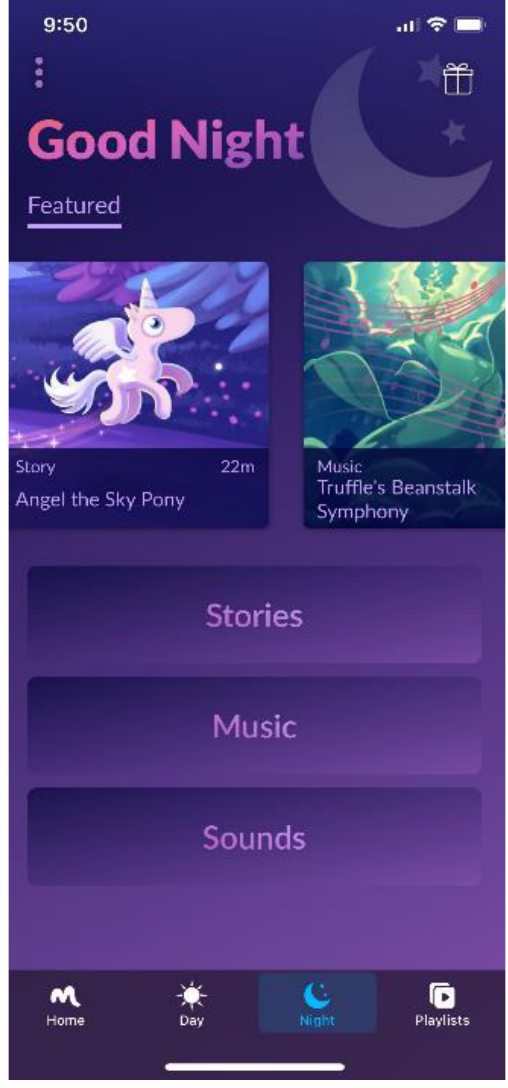
Figure 2. Screenshot of the Moshi audio bedtime stories mobile application.